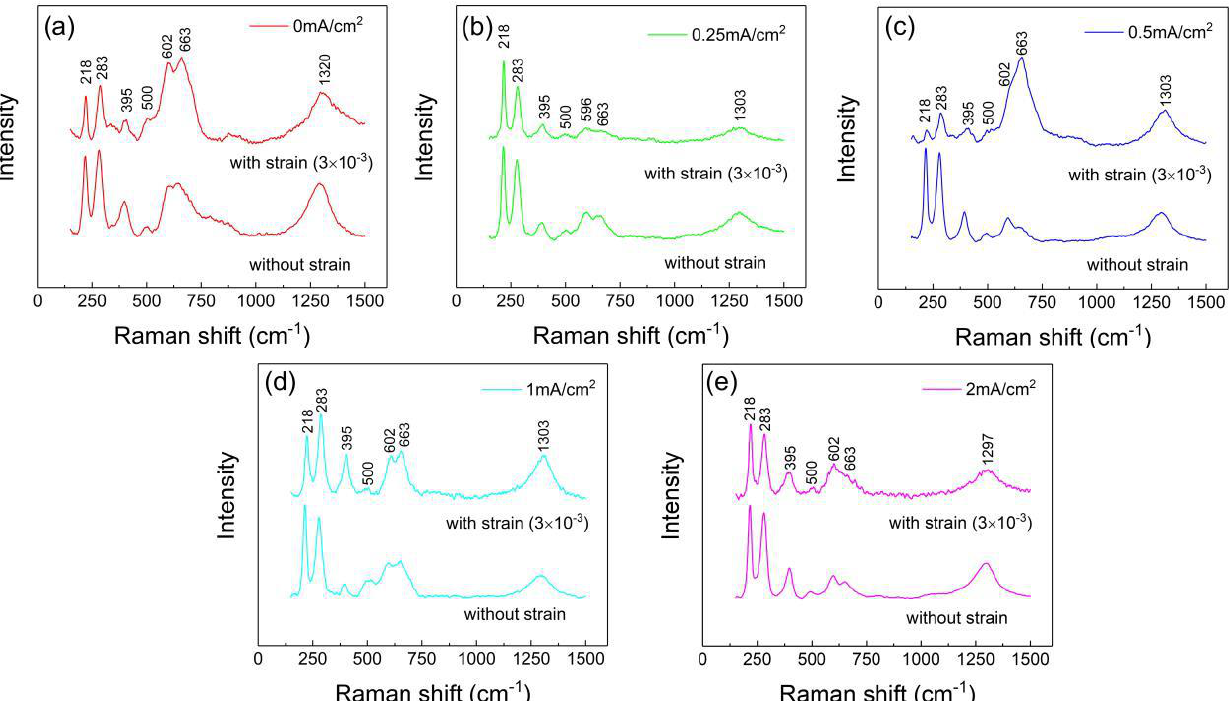
Figure 11. Raman spectra of the corrosion product formed on the X80 steel samples in the NS4 solution under various DC densities and strains: ( a ) i DC = 0 mA/cm 2 , ( b ) i DC = 0.25 mA/cm 2 , ( c ) i DC = 0.5 mA/cm 2 , ( d ) i DC = 1 mA/cm 2 , ( e ) i DC = 2 mA/cm 2 .